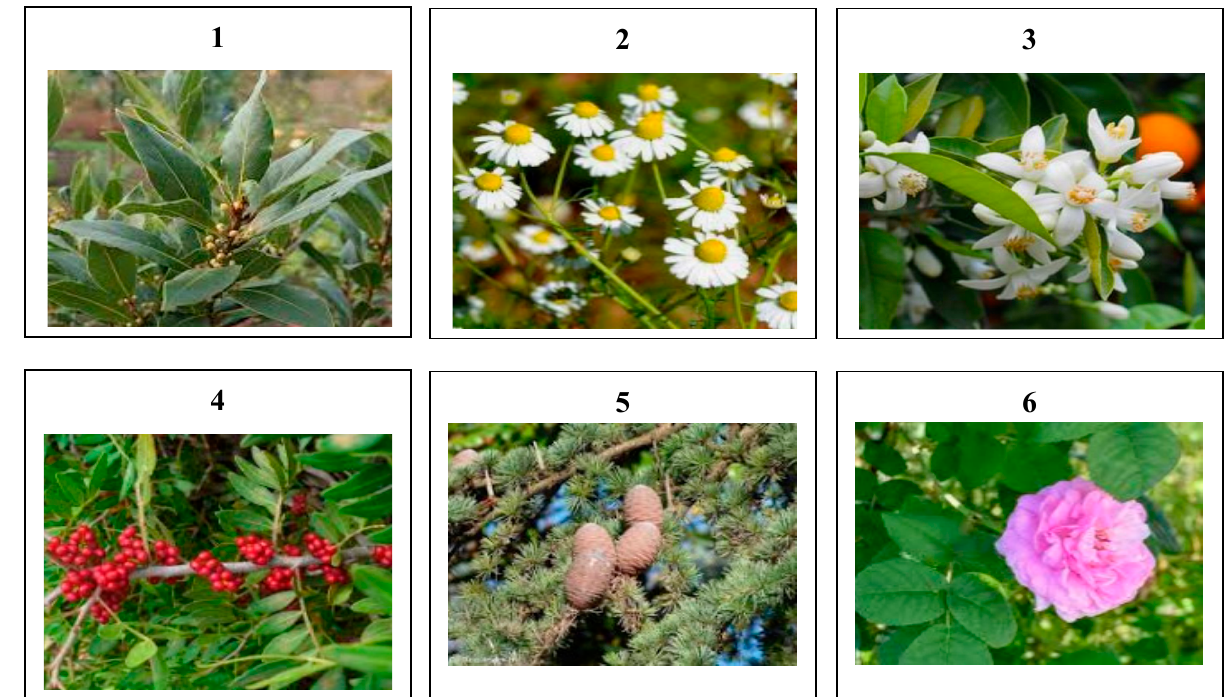
Figure 7. Morphological aspect of the studied plants species: 1 : Laurus nobilis ; 2 : Chamaemelum nobile ; 3 : Citrus aurantium ; 4 : Pistacia lentiscus ; 5 : Cedrus atlantica ; and 6 : Rosa damascena .